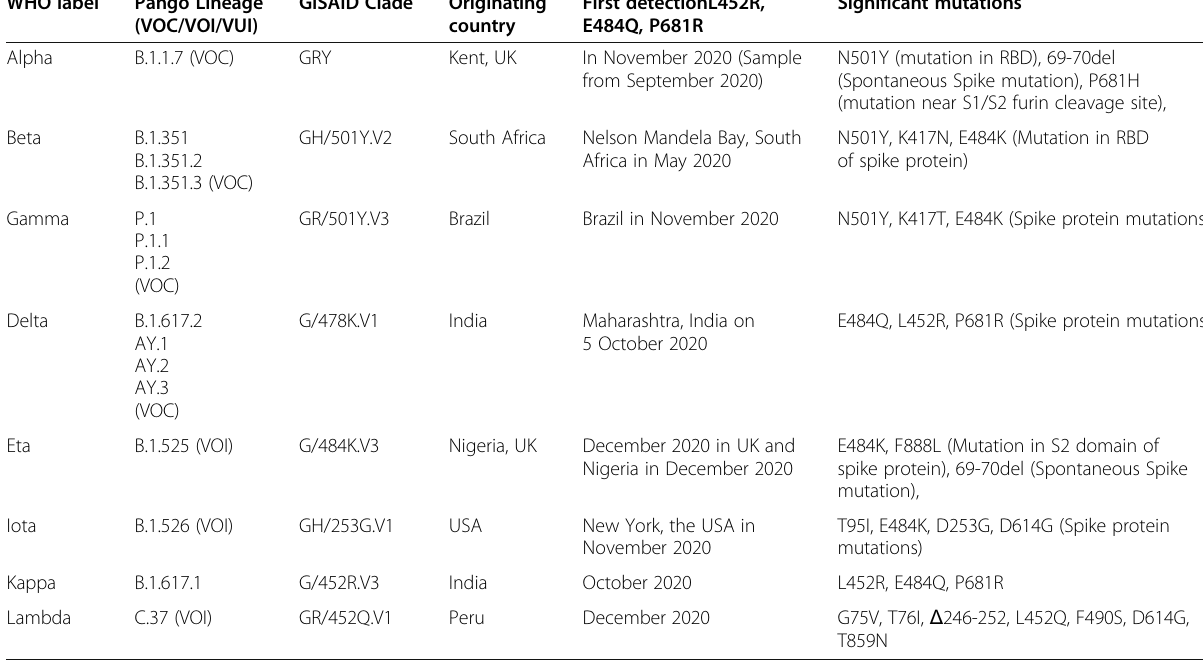
Table 1 Major SARS-CoV-2 Variants in circulation